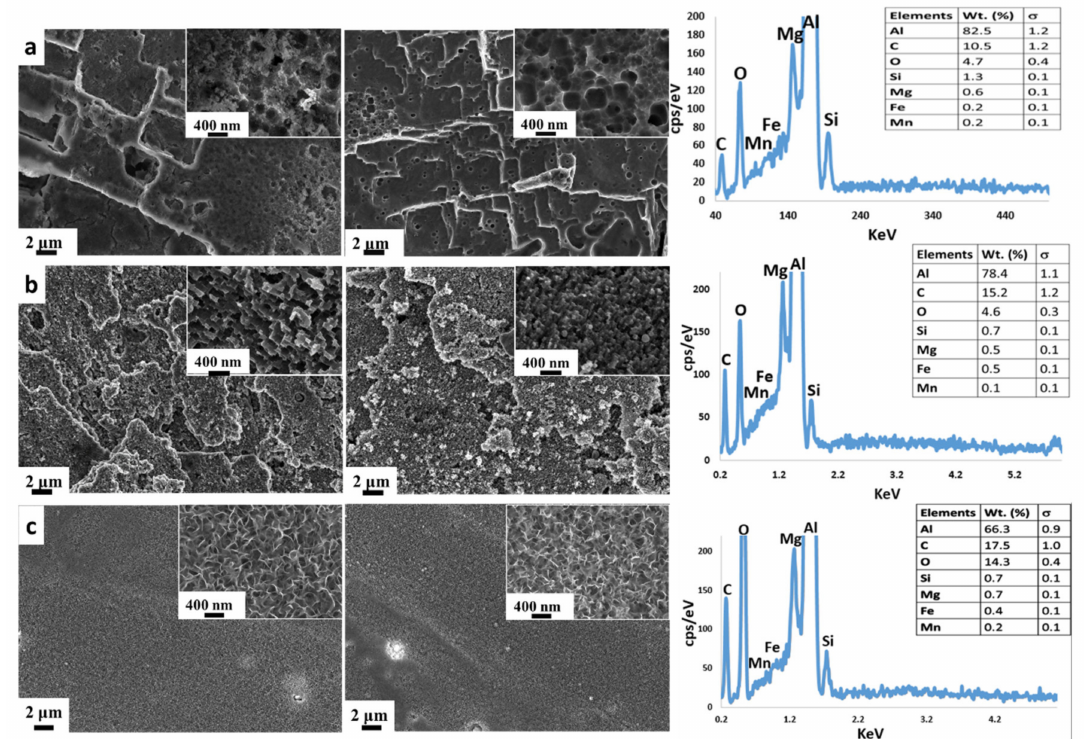
Figure 1. SEM micrographs of the aluminum alloy surfaces before ( left ) and after ( right ) S18 coating deposition. ( a ) Chemical etching in HNO 3 /HCl, ( b ) chemical etching in HF/HCl, and ( c ) boiling water treatment.